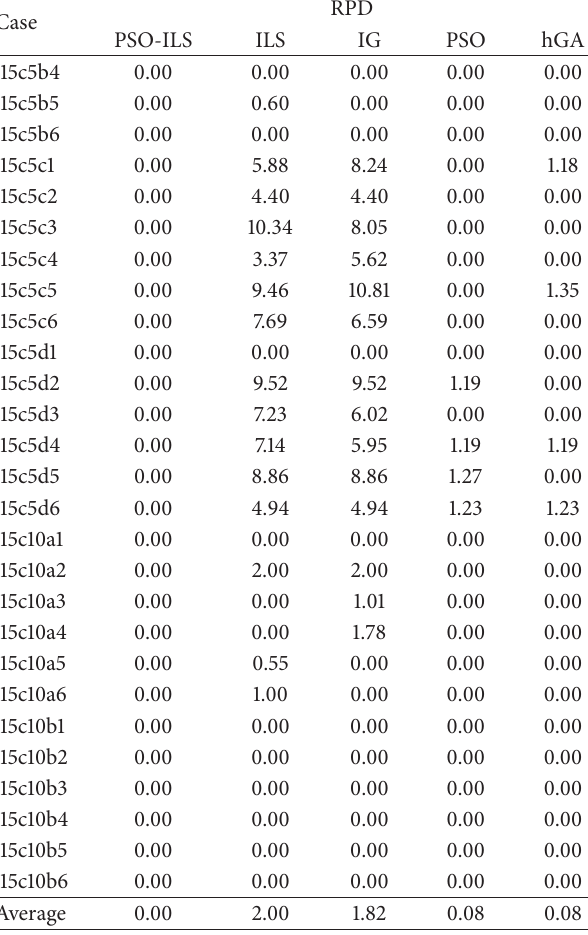
Table 12: Comparisons of the best RPD